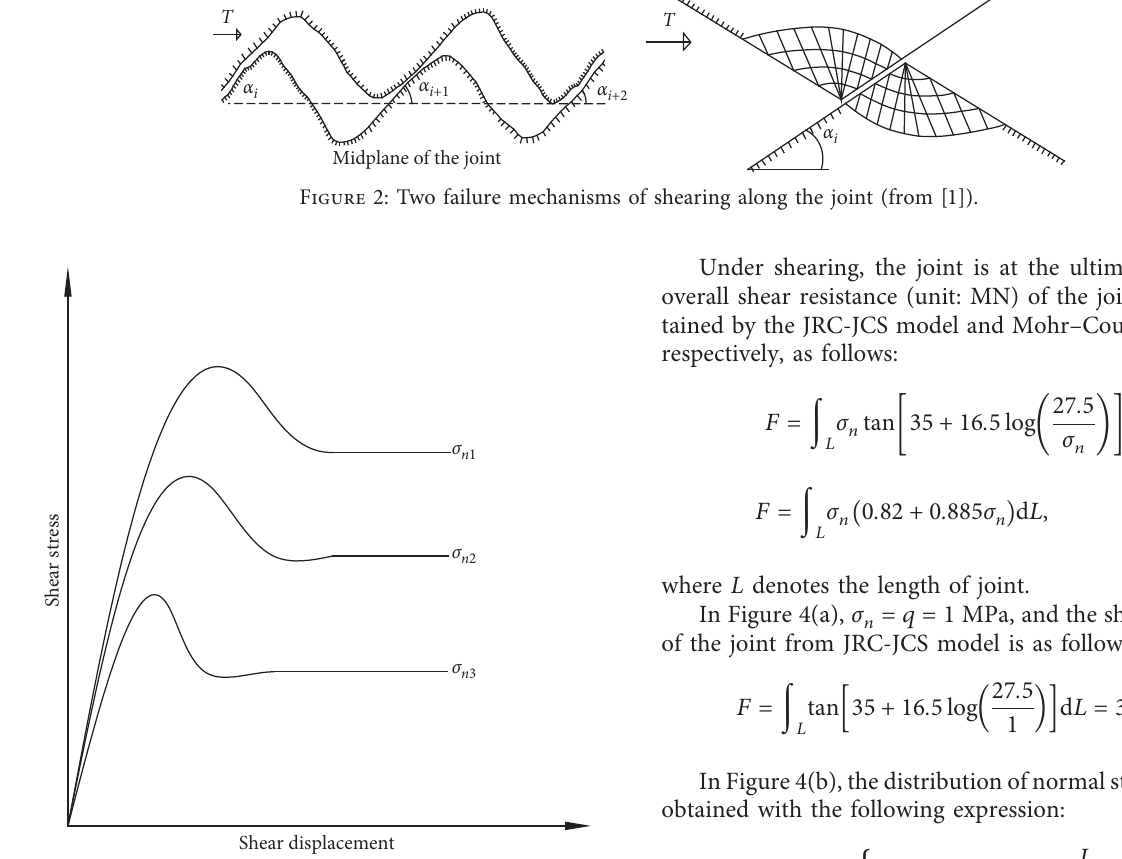
Figure 3: Progressive failure of joint under shearing > σ n > σ n ( σ n 1 2 3